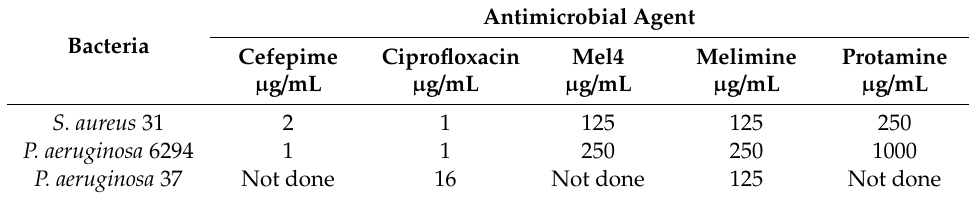
Table 1. Minimum inhibitory concentration (MIC) of the five antimicrobial agents against S. aureus 31, P. aeruginosa 6294 and PA37. Antimicrobial Agent Bacteria Cefepime µ g / mL